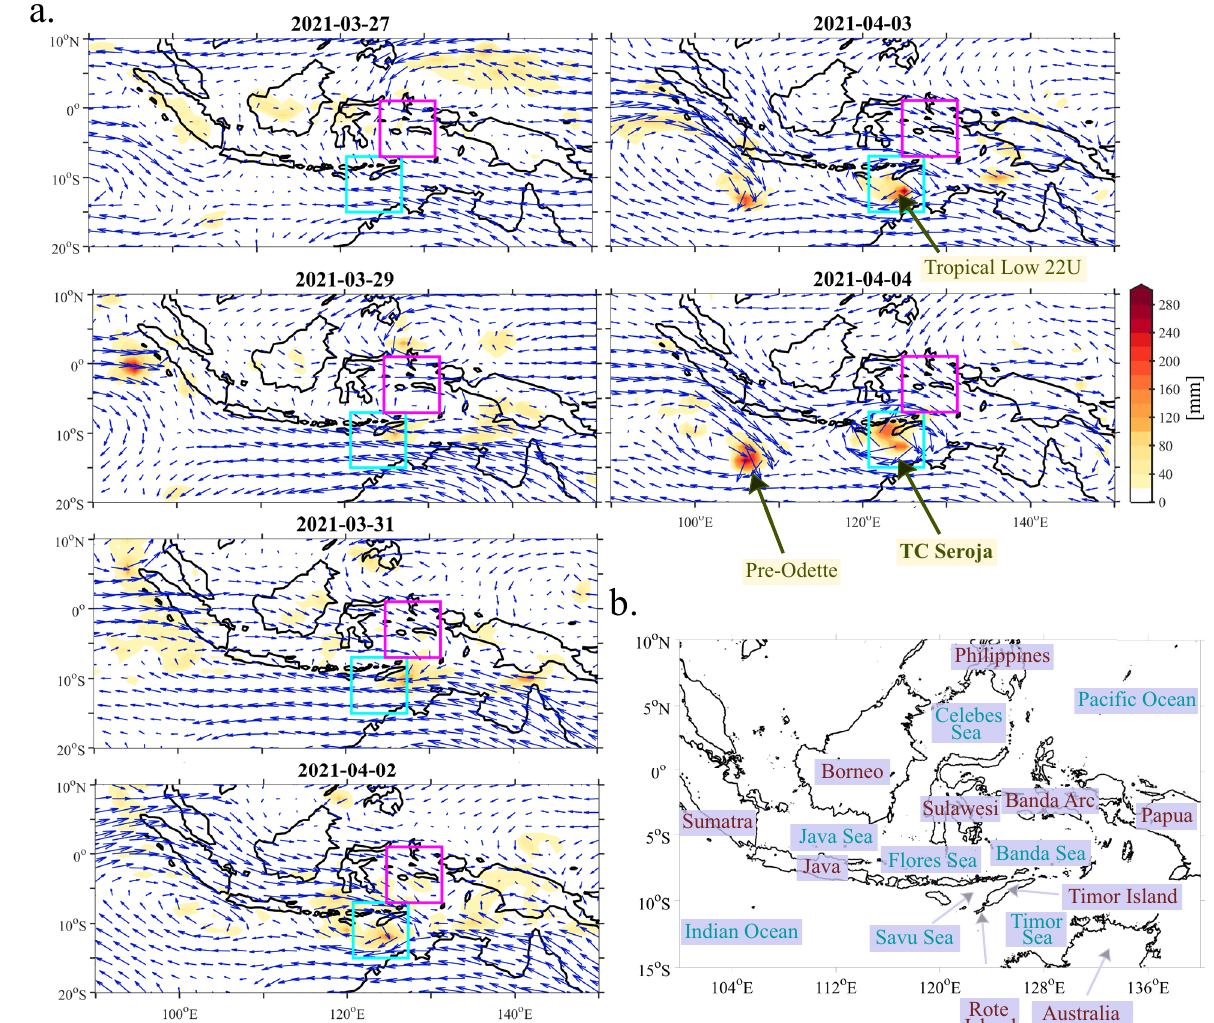
Fig. 1 | Meteorologicalconditionsduring the developmentofTropicalCyclone Seroja over the Maritime Continent. a Daily mean 850hPa ERA-5 winds (arrows) and daily accumulated GPM precipitation based on combined microwave-IR retrievals (shaded in mm) for selected days in March and April 2021. The longest